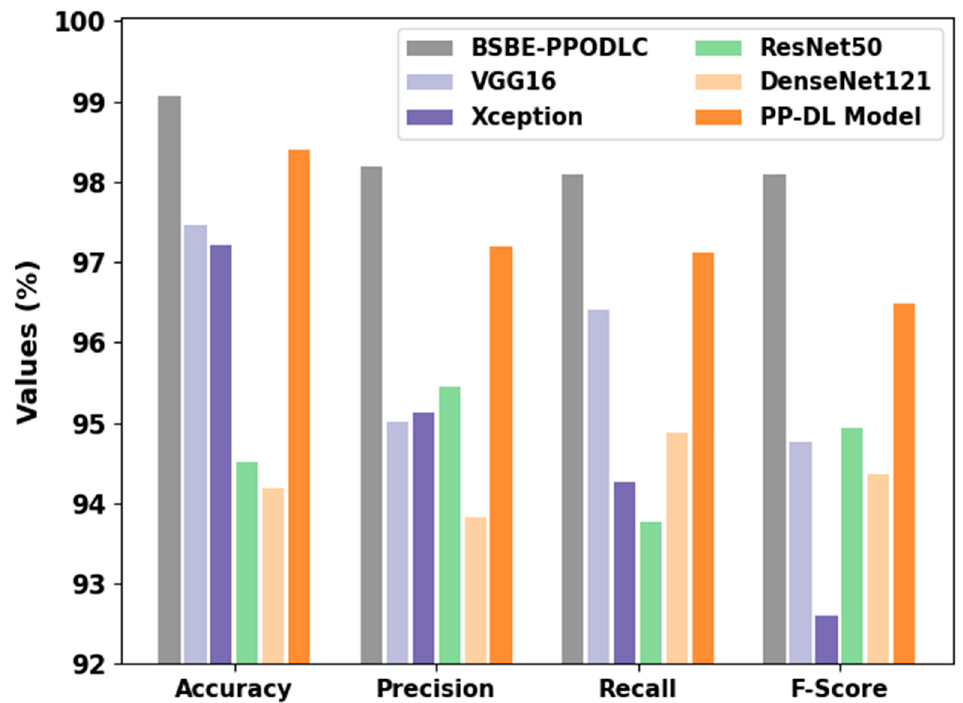
Figure 13. Comparative analysis outcomes of the BSBE-PPODLC approach and other systems.